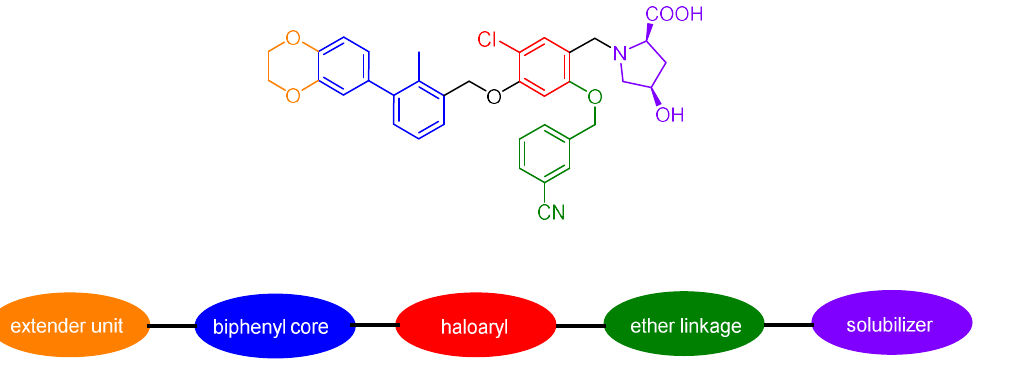
Figure 15. Structural analysis of biphenyl-based small molecule PD-L1 inhibitors [114].